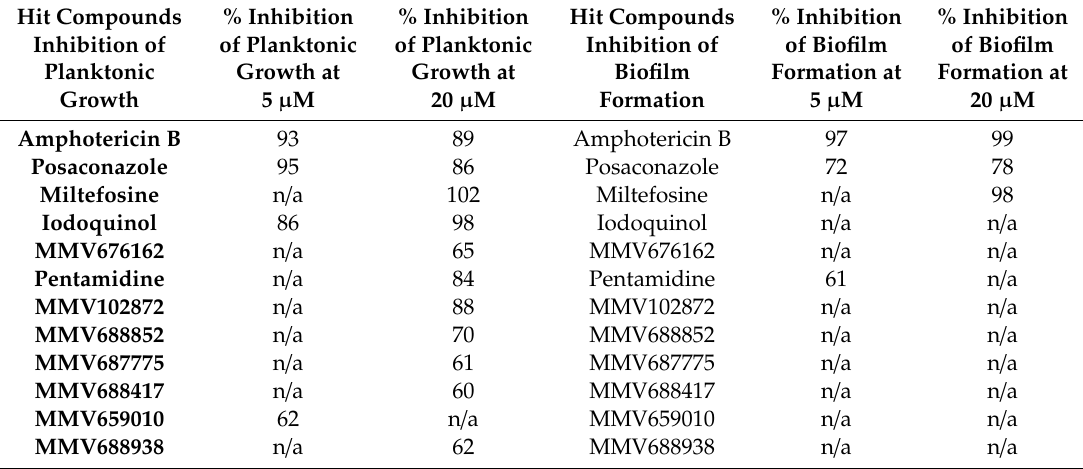
Table 1. Identity and extent of inhibition of compounds identified as “hits” during primary screenings of the Pathogen Box ® in search for compounds with inhibitory activity against C. auris strain 0390 under planktonic and biofilm growing